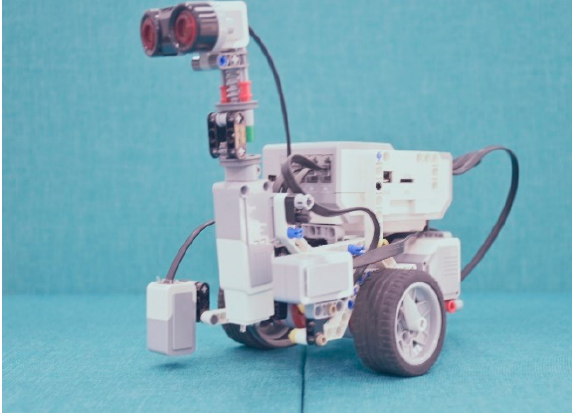
Figure 5. The customized Lego EV3 robot platform.